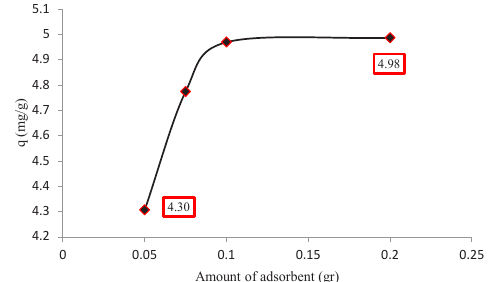
Fig. 3: Effect of adsorbent dosage on the adsorption of Hg (II) Fig.3: EffectofadsorbentdosageontheadsorptionofHg(II)ontoFe 3 O 4 -Polyrhodanine onto Fe3O4